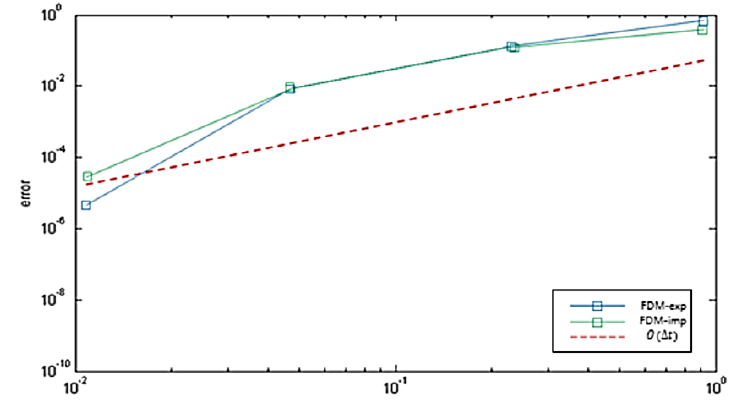
Figure 9. Absolute error for the explicit and implicit finite difference methods